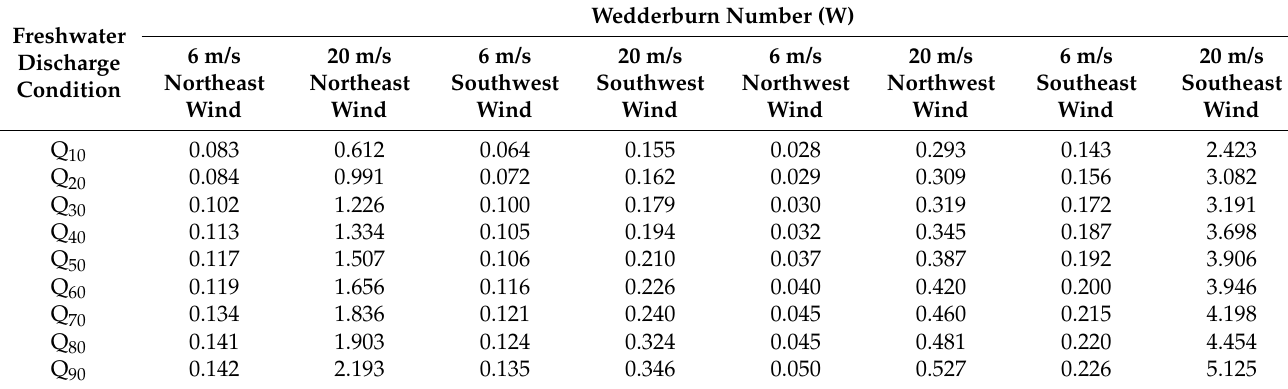
Table 9. Wedderburn numbers under different wind speeds and directions and freshwater discharges from the upstream